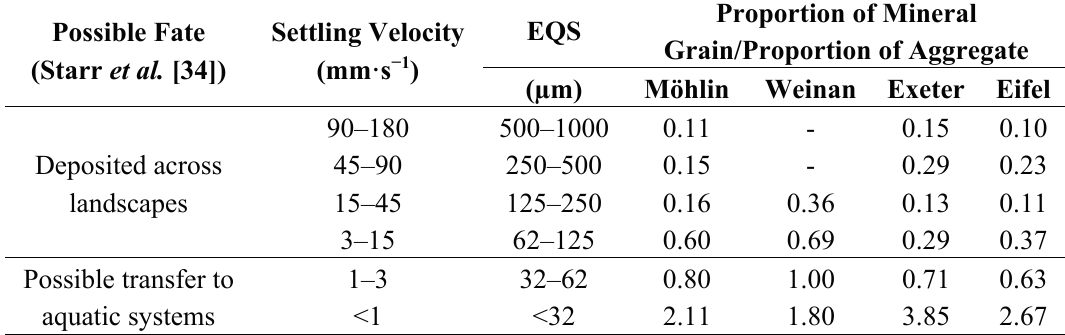
Table 1. Possible fate, settling velocity, and Equivalent Quartz Size (EQS) of each fraction, and ratio of the proportion of each fraction between mineral grain and aggregate (after being impacted by 156 J·m − 2 ). Values greater than 1 mean overestimation without considering aggregation, whereas values smaller than 1 mean underestimation without considering